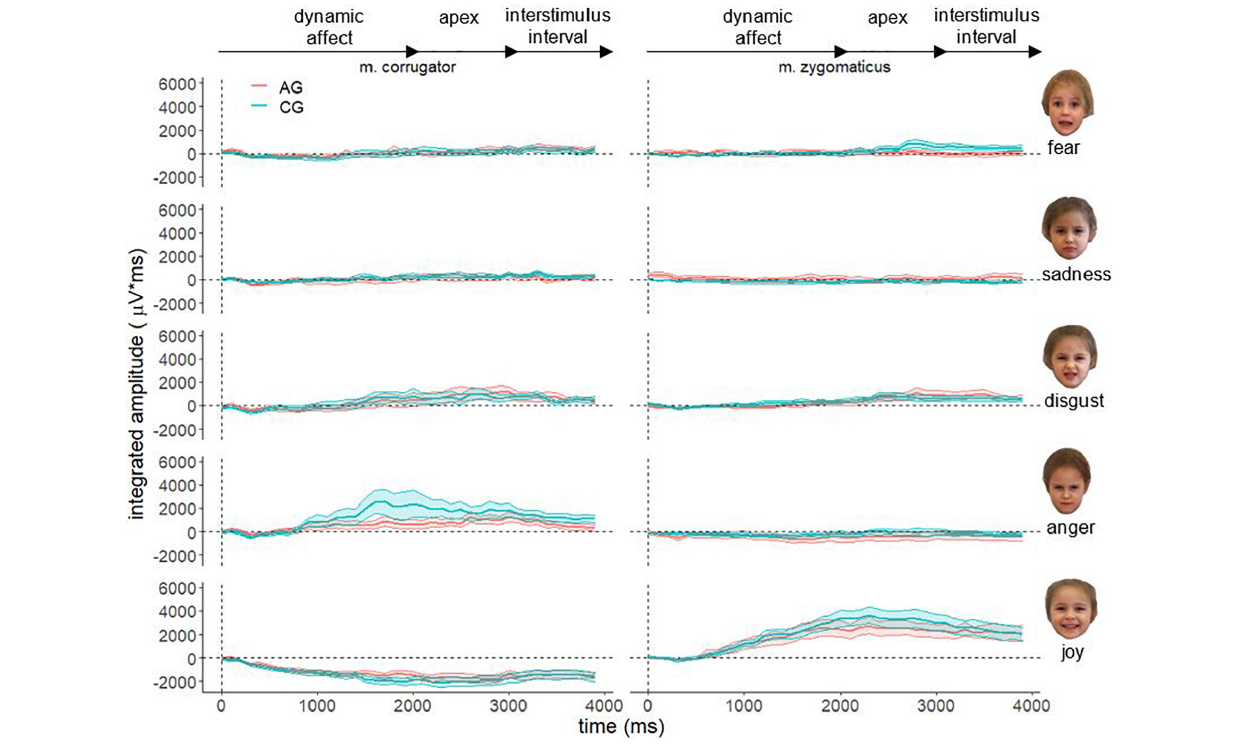
Figure 5 shows the significant interaction effect age × muscle × emotion. The stimuli produced a significantly different fEMG response in the corrugator and